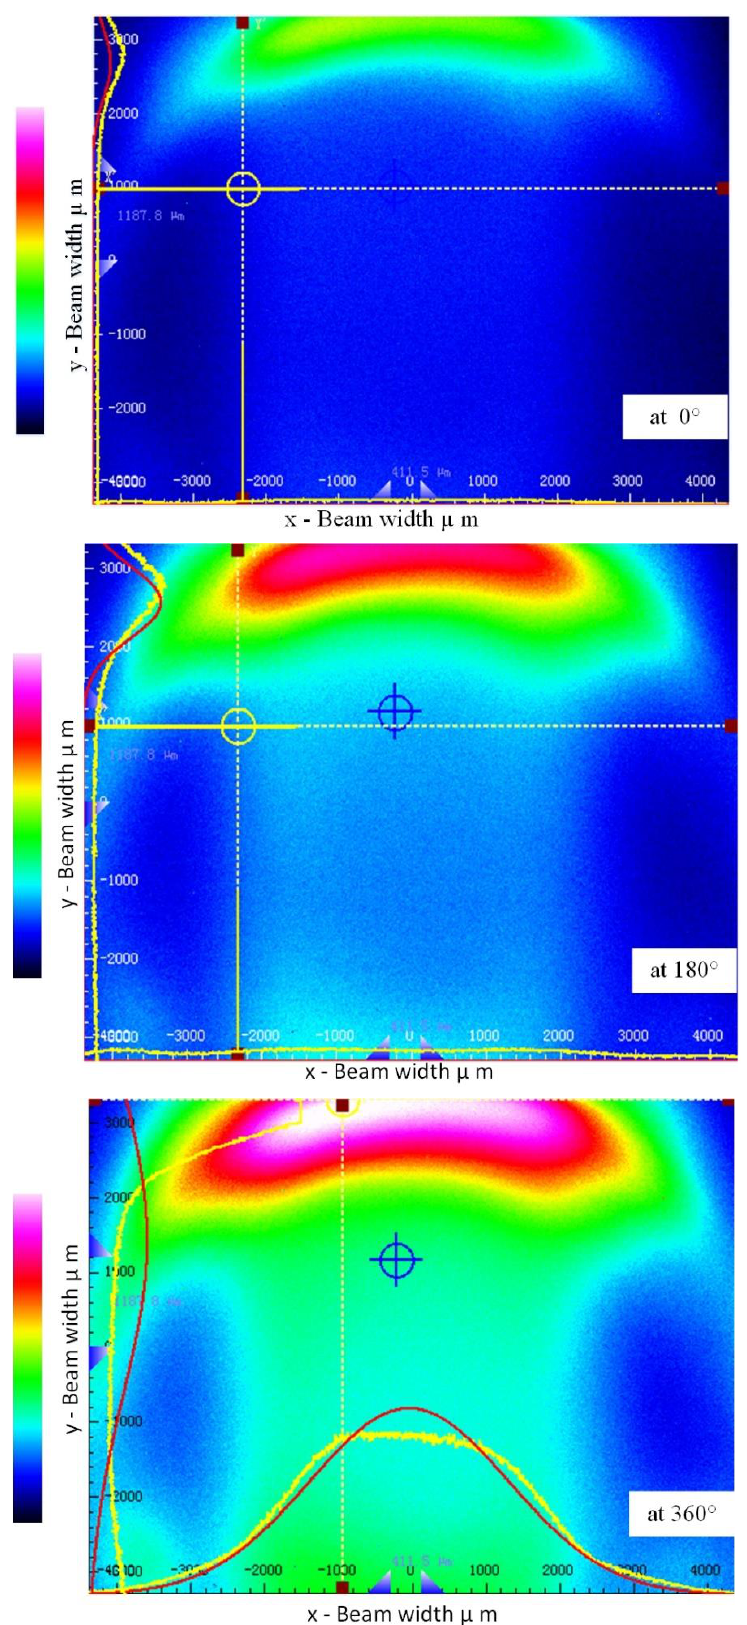
Figure 2. The response of the coupled intensity in the second fiber using a beam quality analyzer.